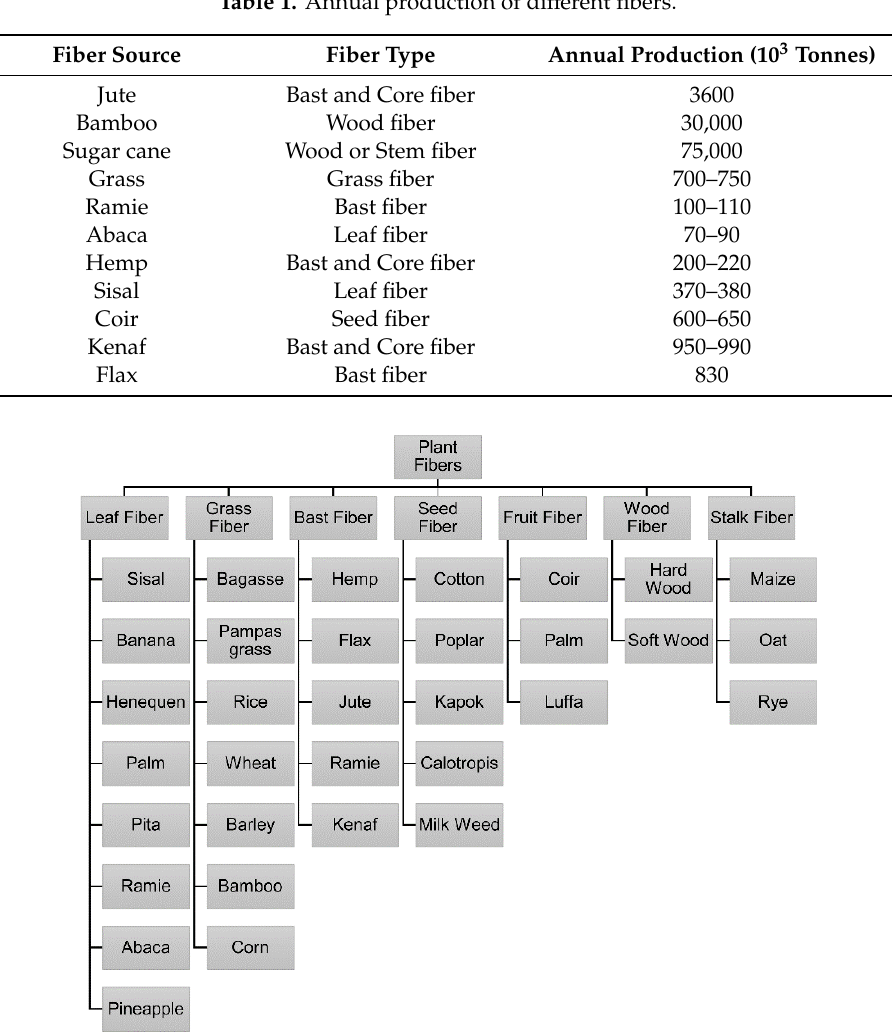
Table 1. Annual production of different fibers.